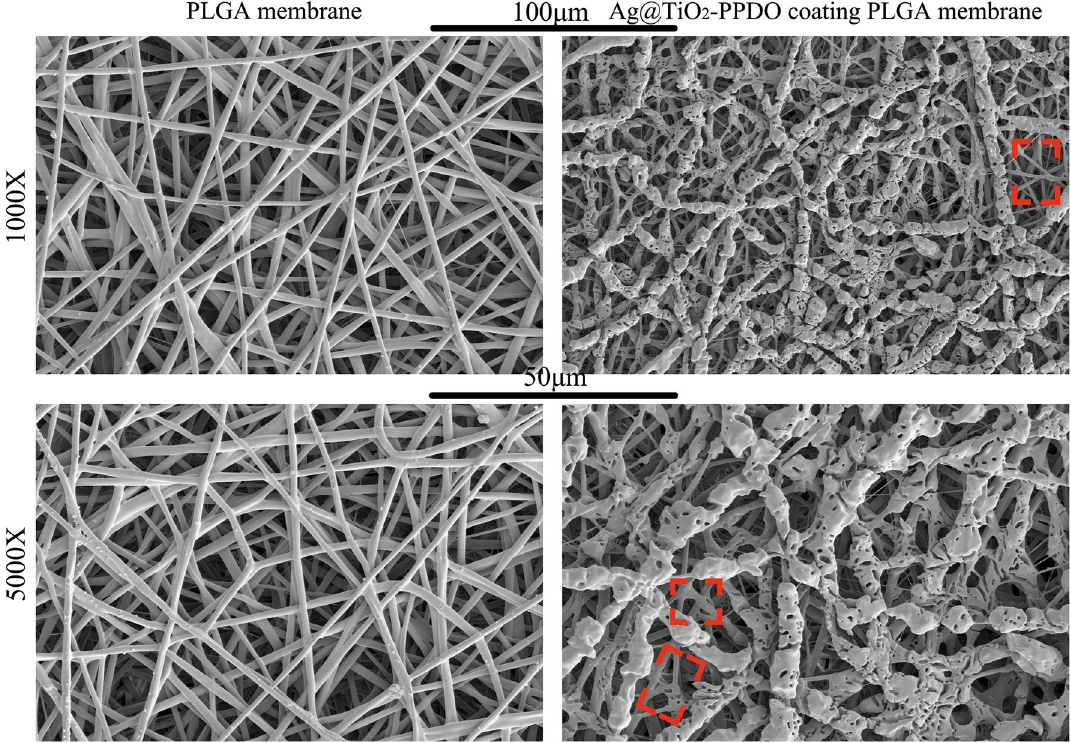
Figure 5. SEM photographs of implanted PLGA electrospun membrane and Ag@TiO 2 -PPDO-coated PLGA membrane. (Red square indicates PLGA membranes under Ag@TiO 2 -PPDO coating).